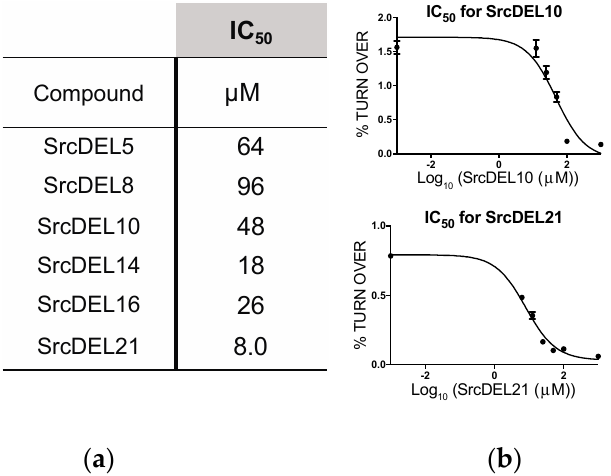
Figure 6. Inhibition of hit molecules in a radiolabel assay with 32 P-ATP (50 µM) and biotinylated-LYNtide (50 µM) as substrates. ( a ) Half maximal inhibitory concentration (IC 50 ) for six hit structures (structures shown in Table 1). ( b ) Representative data for SrcDEL10 and SrcDEL21 .